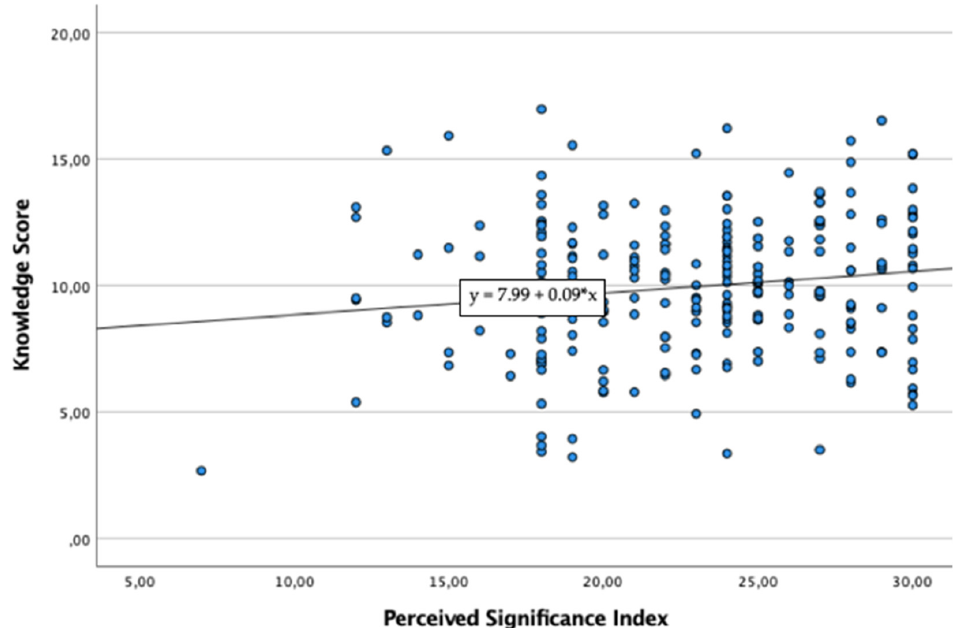
Figure 2. Linear Regression Model between Knowledge Score (dependent variable) and Perceived Significance Index (independent variable/predictor).